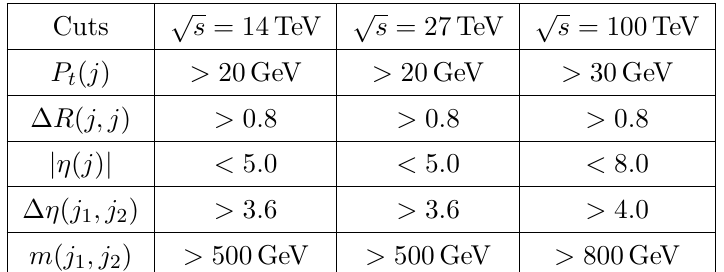
Table 1 . Acceptance cuts used for the calculation of VBF Higgs production in pp collision (VBF cuts), for three different collider energies. The j